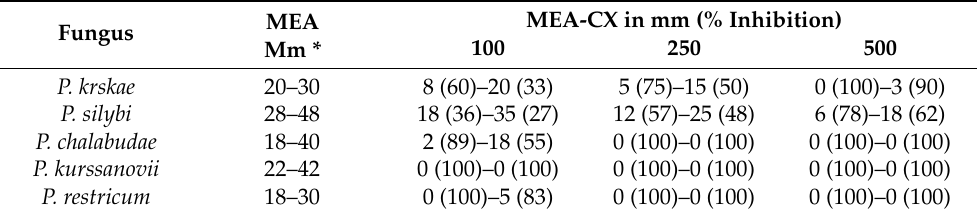
Table 3. Growth response of related Penicillium species in series Restricta to cycloheximide in malt extract agar (MEA-CX) after 7 and 14 days incubation at 25 ◦ C, relative to control with no cycloheximide